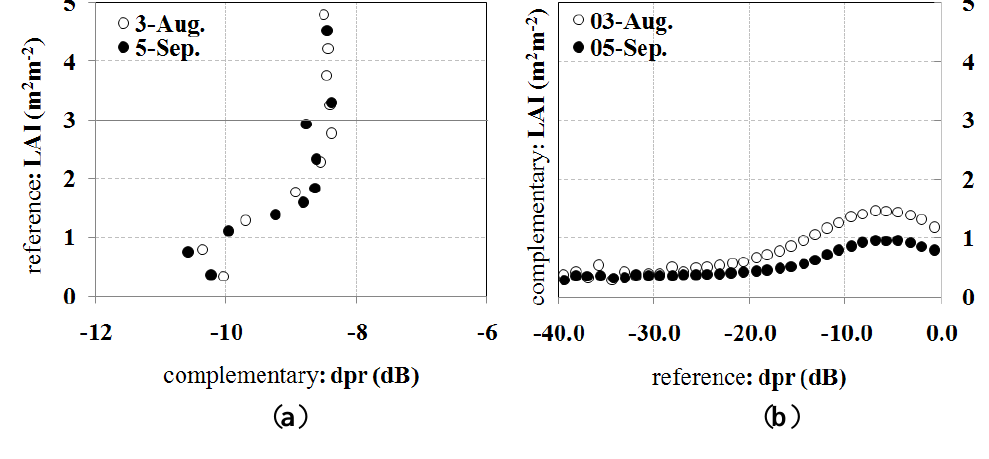
Figure 4. dpr vs. LAI scatterplot according to ( a ) both scheme 1 and ( b ) scheme 2 high